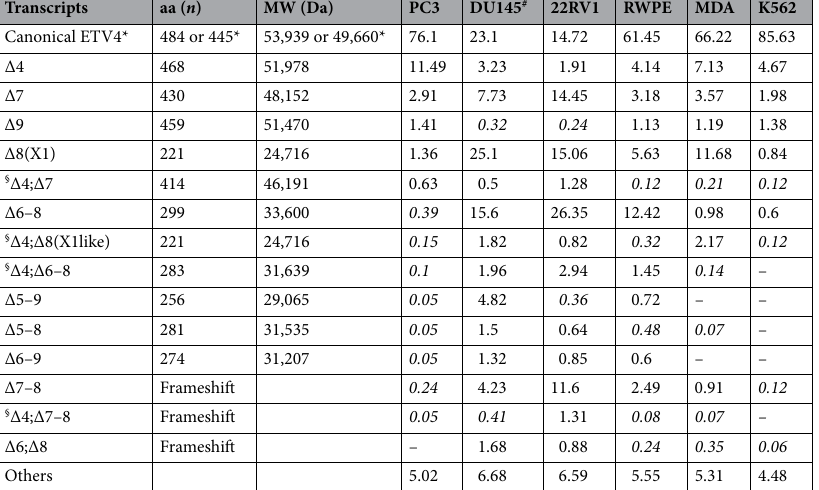
Table 3. Relative abundance of ETV4 variant transcripts by NANOPORE sequencing. Only transcripts found with a frequency ≥ 1% in at least one cell line are shown. The frequency of transcripts under 1% in a specific cell line is reported in italics. A dash (–) indicates that the transcript has not been found. *This transcript includes the canonical ETV4 transcripts with the start codon either in exon 2 (484 aa) or in exon 3 (445